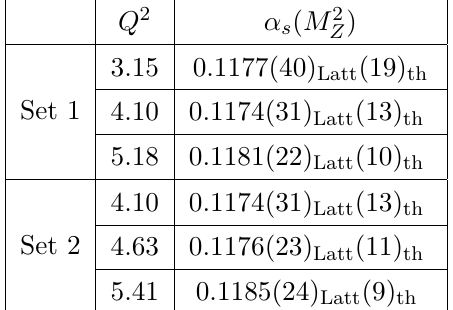
Table 10 . The two sets of three Q 2 points chosen for the averages with their uncertainties using lattice data.